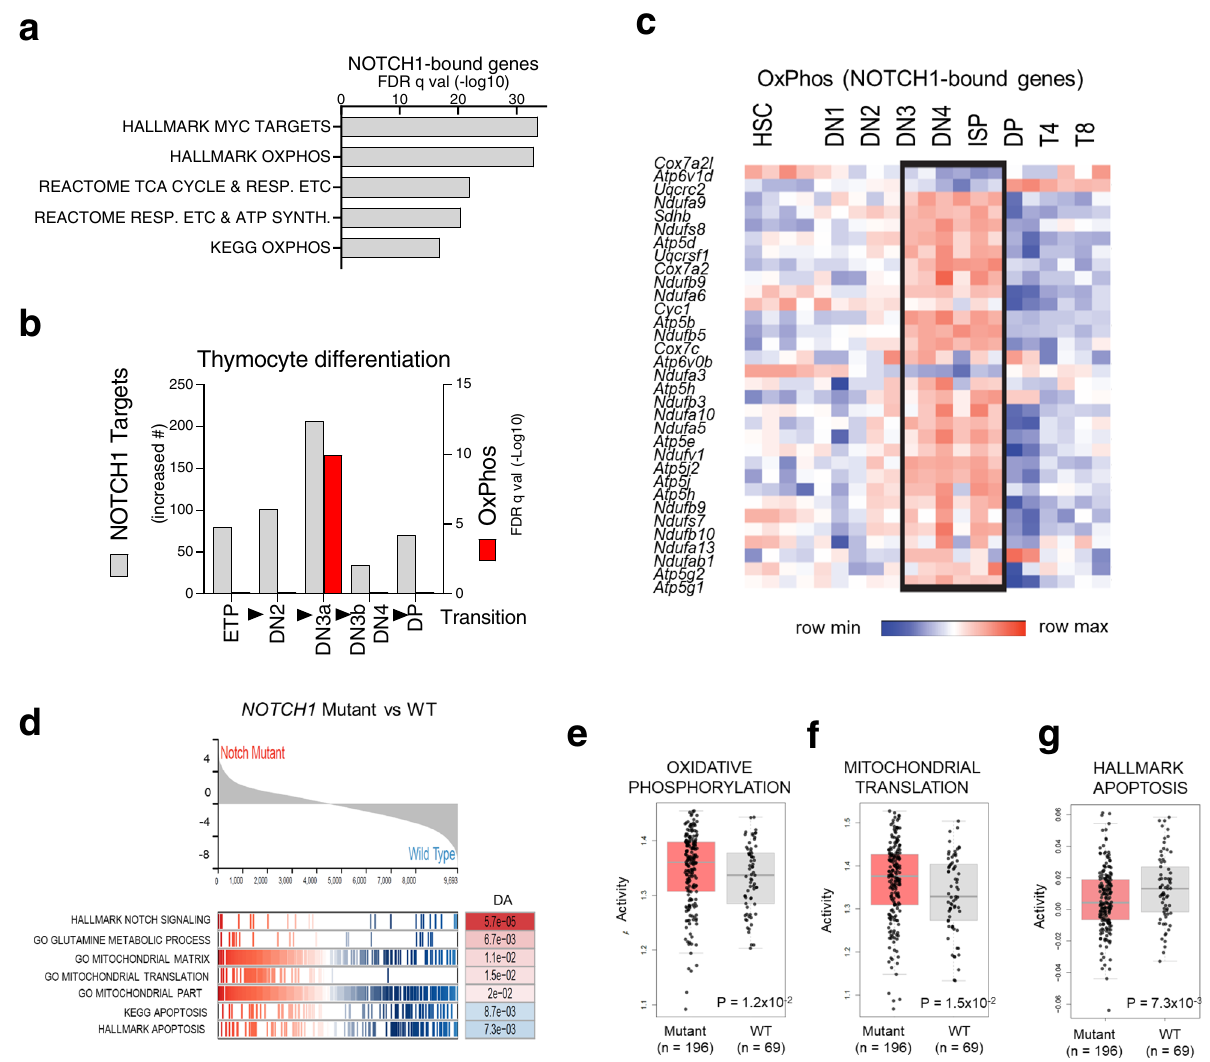
Fig. 1 Oxidative phosphorylation downstream of NOTCH1 is essential for preleukemic stem cells function. a Gene set enrichment analysis of NOTCH1- bound genes in Molecular Signatures Database. The list of genes in which NOTCH1 binding was observed within 2 kb of transcription start sites in murine T-ALL cell lines was extracted as described in Materials and Methods. False discovery rates (FDRs) are shown for overlaps computed with Hallmark gene sets or canonical pathways (Reactome and Kyoto Encyclopedia of Genes and Genomes). TCA: tricarboxylic acid; ETC, electron transport chain. b Dynamics of NOTCH1 target gene expression during thymocyte differentiation. The numbers of NOTCH1 target genes that increased >1.3-fold at each transition (gray bars, left axis). Gene expression data are from the Immunological Genome Project. GSEA was conducted on the gene sets whose expression increased at each transitional stage. FDR values overlap with the OxPhos gene set (Hallmark) were computed as above (green bars, right axis). ETP, early T-lineage precursor; DN3a, (CD4 − CD8 − CD25 + CD44 − CD28 − ), DN3b, (CD4 − CD8 − CD25 + CD44 − CD28 + ). c Heatmap of expression of NOTCH1-bound genes within the OxPhos pathway. Ultralow input (ULI) RNA-seq data were obtained from IMMGEN. ETP, early thymocyte progenitor (Lin low CD25 − CD44 + Kit + ), DN2, double negative 2 (Lin low CD25 + CD44 + Kit + ), DN3 (CD4 − CD8 − CD25 + CD44 − ), DN4 (CD4 − CD8 − CD25 − CD44 − CD28 + ), ISP, immature single positive (CD4 − CD8 + CD24 hi TCR lo ), DP (CD4 + CD8 + TCR lo CD24 hi ), T4 (CD4 + CD8 − − TCR hi ), T8 (CD4 − CD8 + TCR hi ). d GSEA of the TARGET gene set (Therapeutically Applicable Research to Generate Effective Treatments) ( N = 265), indicated enrichment of genes related to glutamine metabolism, mitochondrial metabolism as well as translation and downregulation of apoptosis-related genes in patients with NOTCH1 -mutations (each vertical bar in x - axis is gene rank in the pathway list and y -axis represents running enrichment score). e The OxPhos gene signature in T-ALL patients from TARGET cohort. f Enrichment of mitochondrial translation genes in T-ALL patients from TARGET cohort. g Enrichment of apoptosis-related genes in T-ALL patients from the TARGET cohort; for ( e ), (f ) and ( g ) : two-sided t -test; The center line represents the median and whiskers represents maximum (Q3 + 1.5*IQR) and minimum value (Q1 +